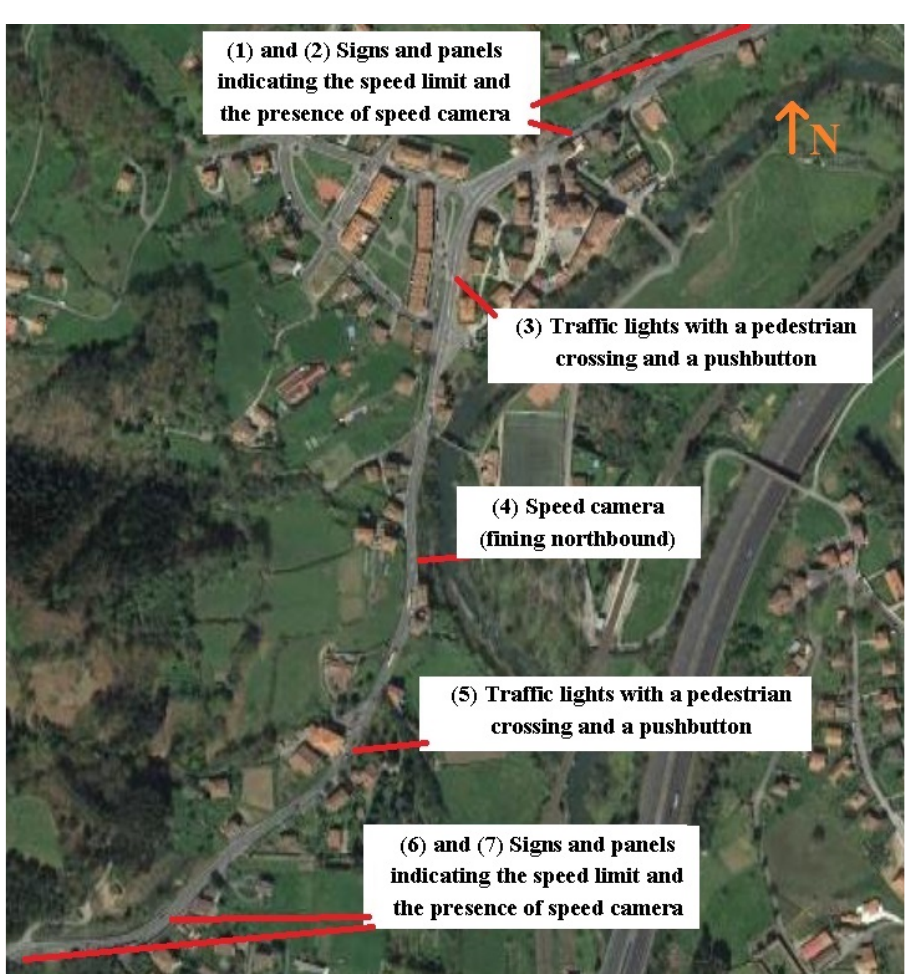
Figure 4. Locations of the traffic calming measures and other elements in Arrankudiaga (Spain). Measurements were carried out at the pedestrian crossings with traffic lights and pushbuttons (3) and (5) and at the radar speed camera (4) northbound. Once again, points are referred to as N3, N4, and N5 or S3, and S5, depending on the controlled direction, northbound and southbound, respectively.